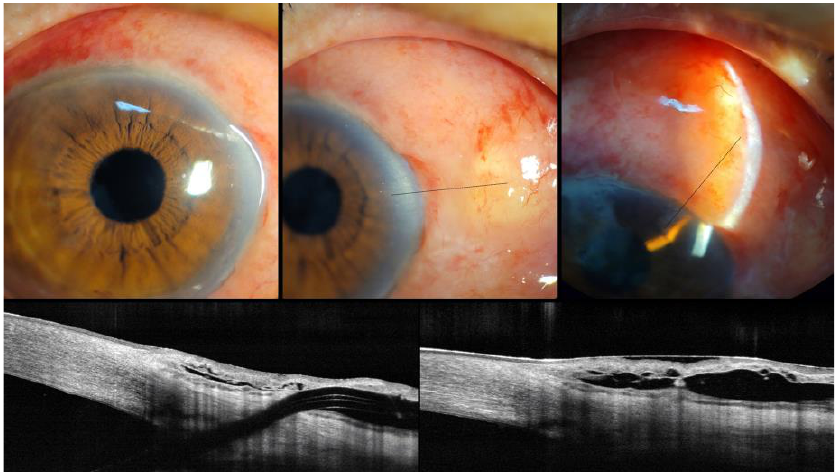
Figure 2. Anterior segment photography and AS-OCT demonstrated relatively well-functioning filtering bleb at 7 days after XEN implantation. (Black line: linear scan line on AS-OCT). During the follow-up period, the hypovascular bleb gradually changed into an avas- cular bleb. Periocular pain and tearing developed 18 months after the initial operation, with mild deterioration of visual acuity from 20/50 (LogMAR 0.4) to 20/100 (LogMAR 0.7). Slit-lamp examination revealed a small defect in the conjunctiva, corresponding to the exit point of the XEN. The Seidel test result was weakly positive; however, the patient’s IOP